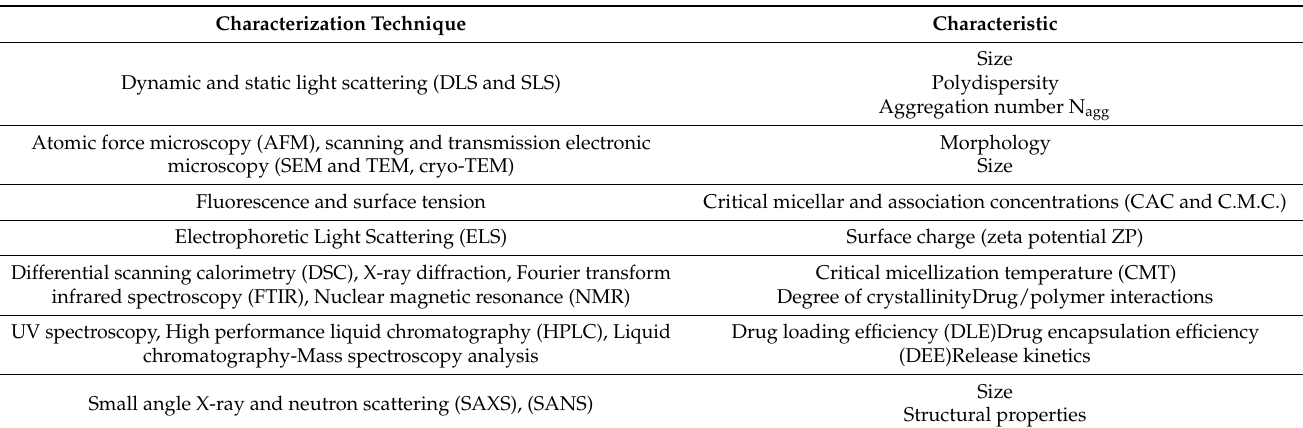
Table 2. Characterization techniques and main characteristics of drug-loaded micellar